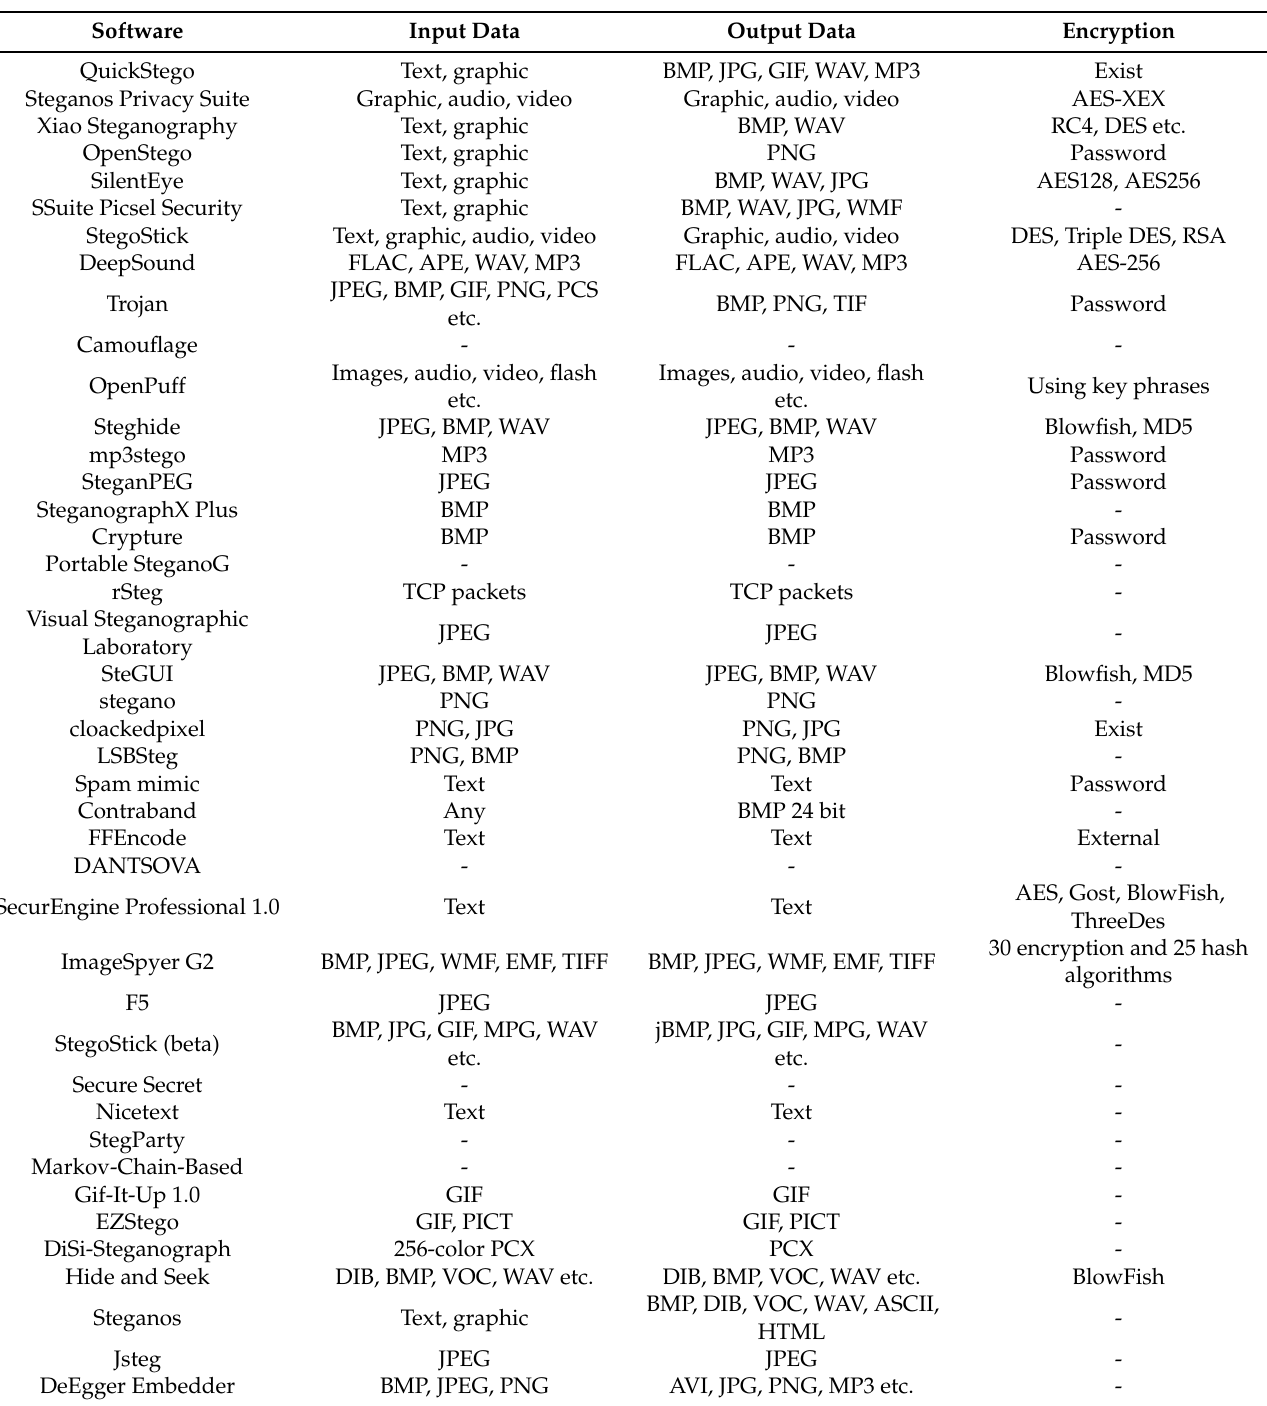
Table 2. Comparative table of the main software solutions for stego-message